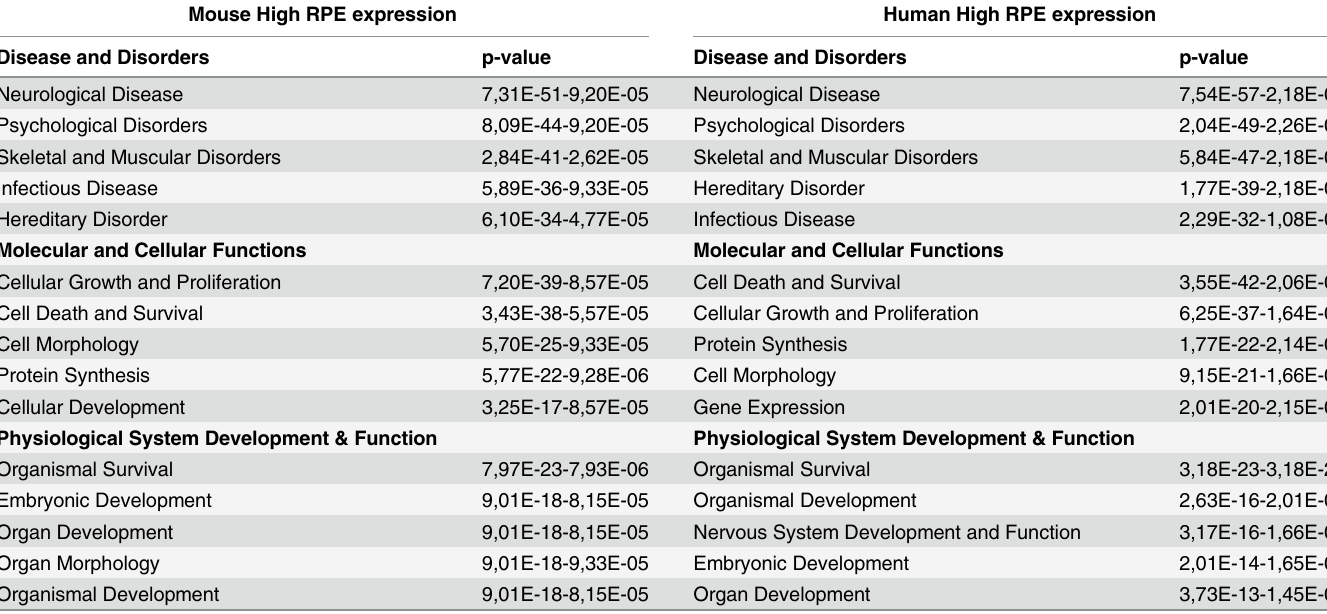
Table 3. Overview of the major biological functions found in a functional annotation by Ingenuity of the “ Mouse High RPE gene expression ” and “ Human High RPE gene expression ” datasets. Mouse High RPE